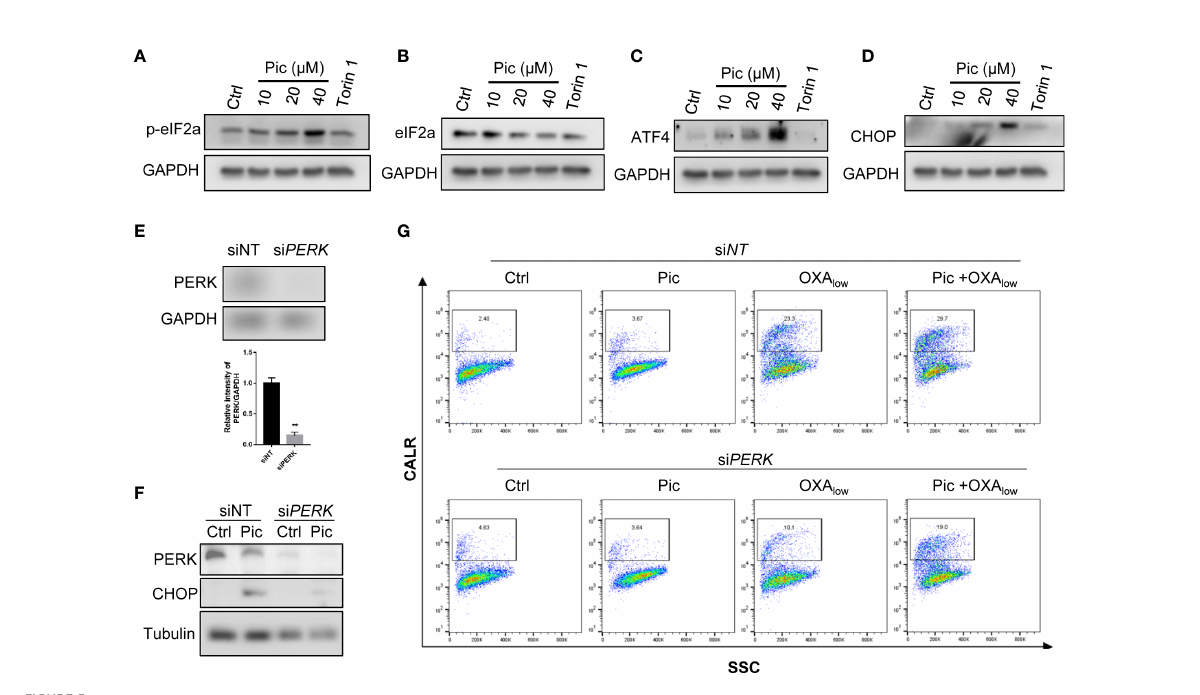
FIGURE 5 ER stress-mediated PERK activation is required for the role of Pic in enhancing OXA-induced CALR exposure. (A, B) Pic increases the phosphorylation of eIF2 a . U2OS cells were treated with Pic (10-40 m M) for 24 h, p-eIF2 a (A) and total eIF2 a (B) were detected by western blotting. Torin 1 treatment was use as a positive control. (C, D) Pic increases the expression of canonical ER stress marker ATF4 and CHOP. U2OS cells were incubated with Pic (10-40 m M) for 24 h, ATF4 (C) and CHOP (D) were detected by western blotting. (E, F) knocked down the expression of PERK attenuates Pic-induced increasing of ER stress marker CHOP. U2OS cells were transfected with PERK-speci fi c siRNA for 48 h (E, F) , and then treated with Pic (40 m M) for another 24 h, and the expression of CHOP was detected (F) . (G) Knockdown of the expression of PERK attenuates the combination effect of Pic and OXA in promoting cell surface CALR exposure. Cell surface CALR exposure was measured by Flow cytometry analysis. ** p -value